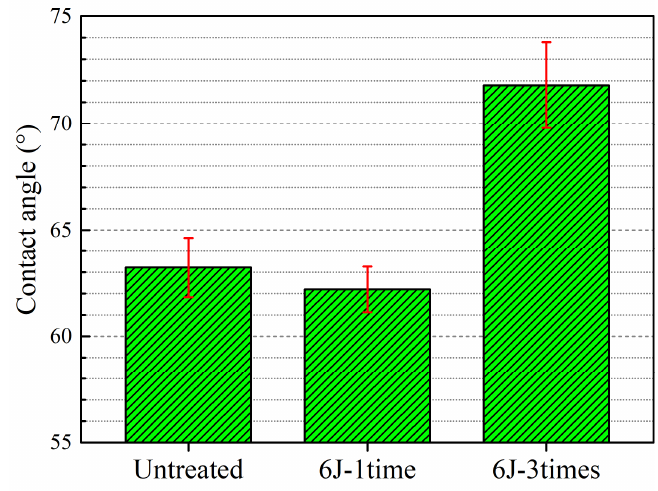
Figure 3. Contact angle of experimental coupons.